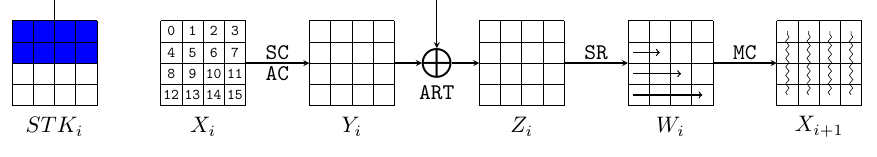
Figure 3: The i th round of SKINNY.